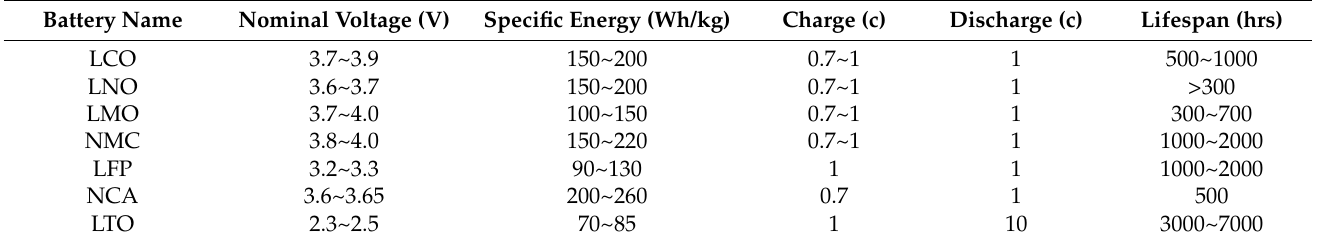
Table 2. Comparison of different Li-ion batteries and their characteristics